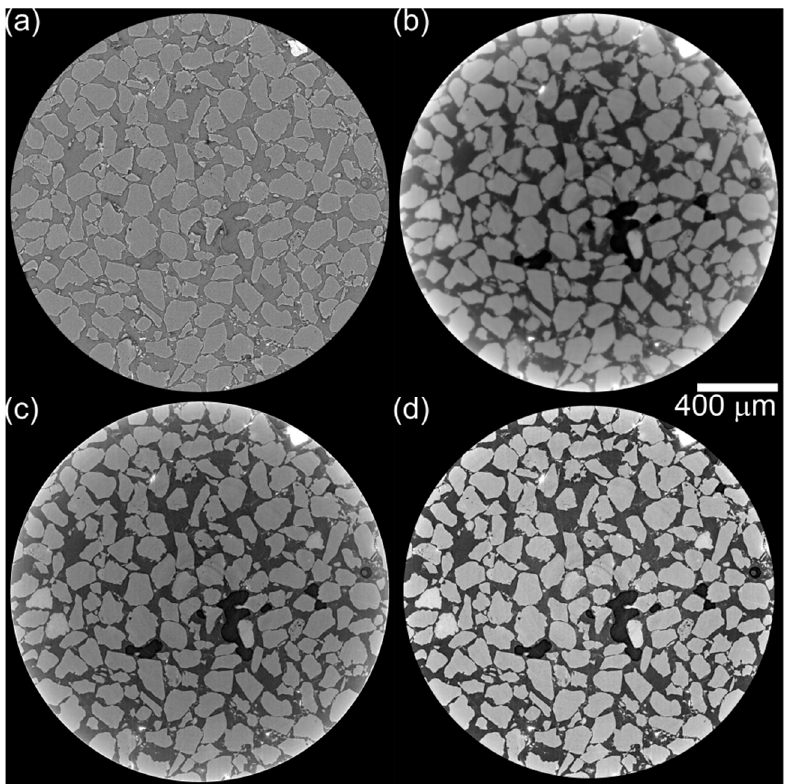
Figure 3. Slice 1050 of an intermediate-contrast SXCT dataset showing the output of the reconstruction and post-processing stages: ( a ) reconstruction through absorption contrast pipeline; ( b ) reconstruction through phase contrast pipeline; ( c ) output from filtering and volume averaging; ( d ) Cupping correction output.